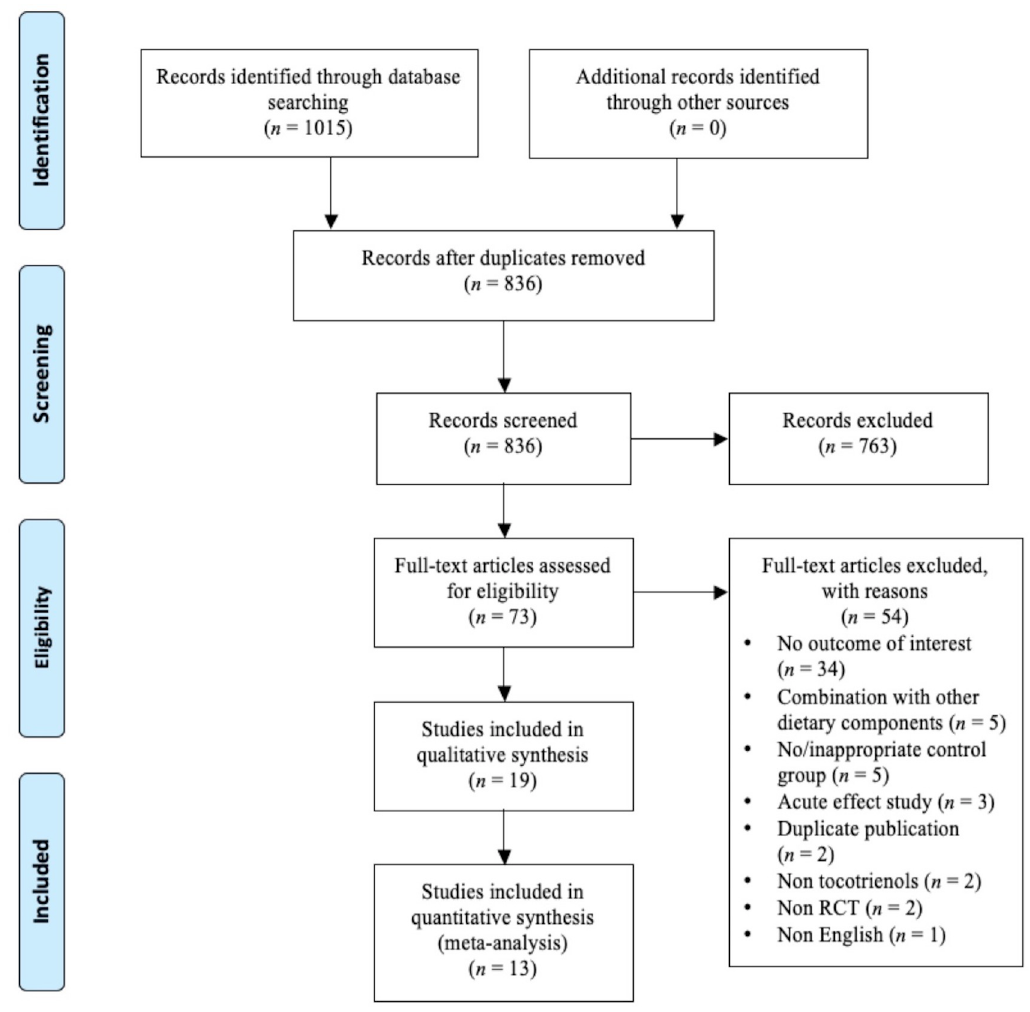
Fig 1. Flow diagram of study